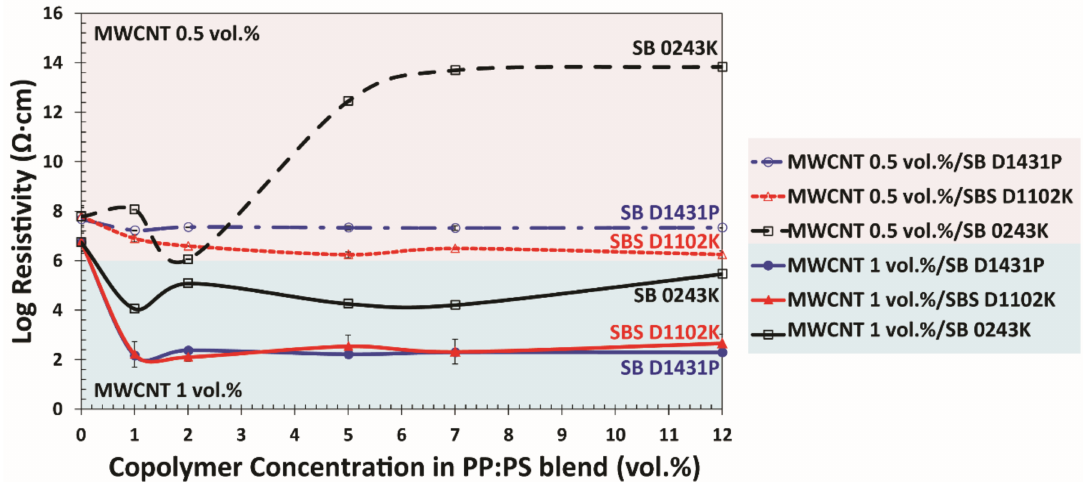
Figure 9. Electrical resistivity of blend nanocomposites with 0.5 vol.% (pink-shaded area) and 1.0 vol.% (blue-shaded area) MWCNT concentration as a function of copolymer content.